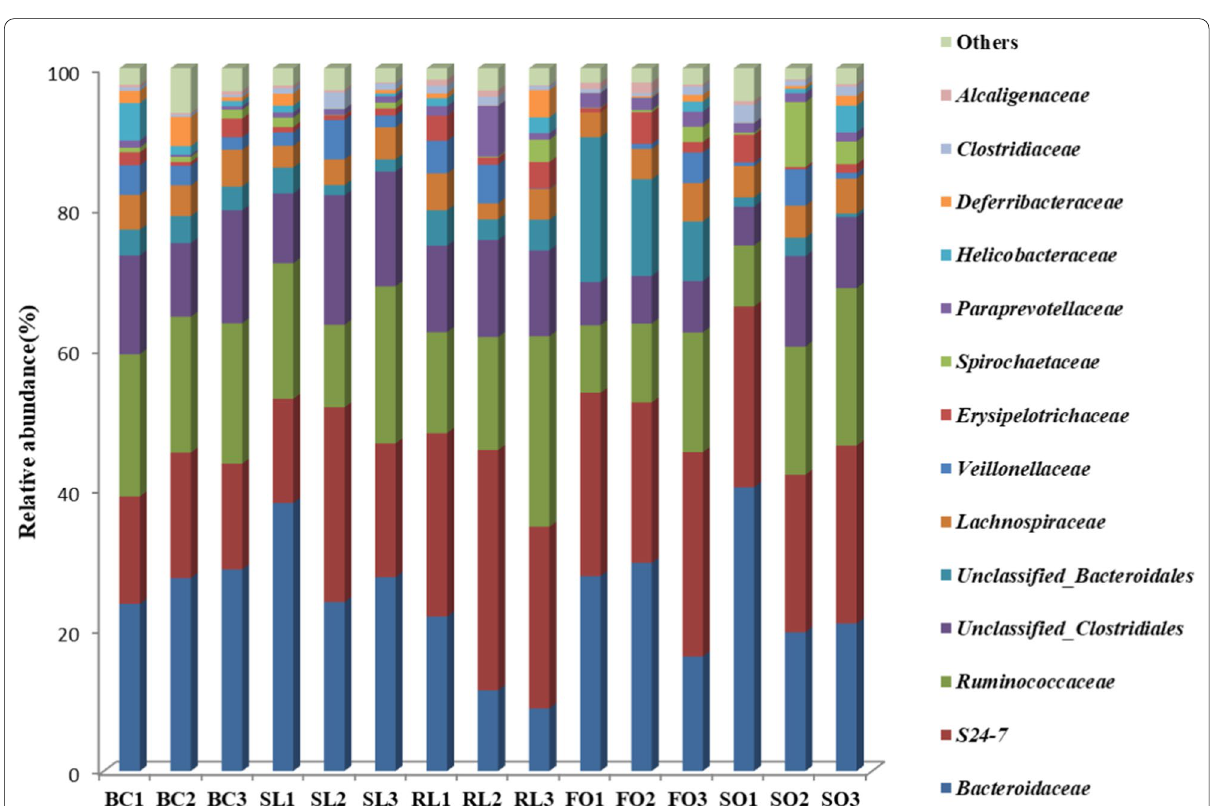
Fig. 4 Effect of stewed lard, refined lard, fish oil and soybean oil on the family level of intestinal flora in